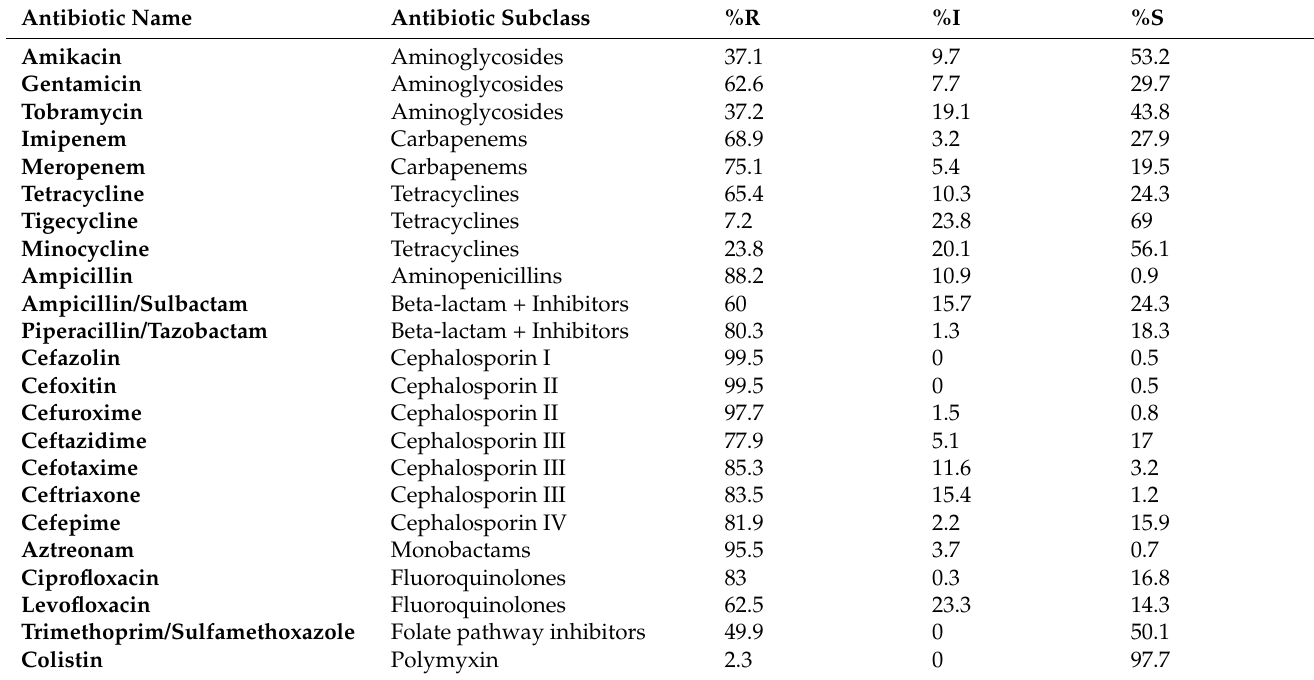
Table 4. Antibiotic susceptibility pattern of A. bummanii by Vitek